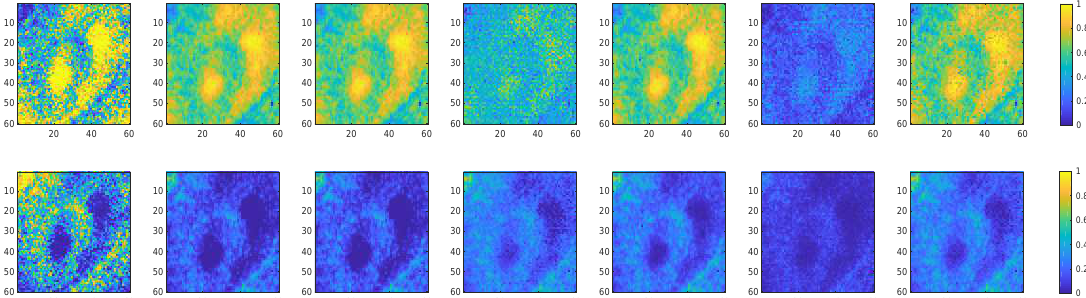
Figure 6. Abundances maps of S 5 . From left to right columns: ground-truth, estimated abundances of FCLS, SUnSAL, K-Hype ( G ), NDU ( G ), IIKNMF ( G ), proposed ( G ). From top to bottom rows: distributions of red quartz sand and green quartz sand.